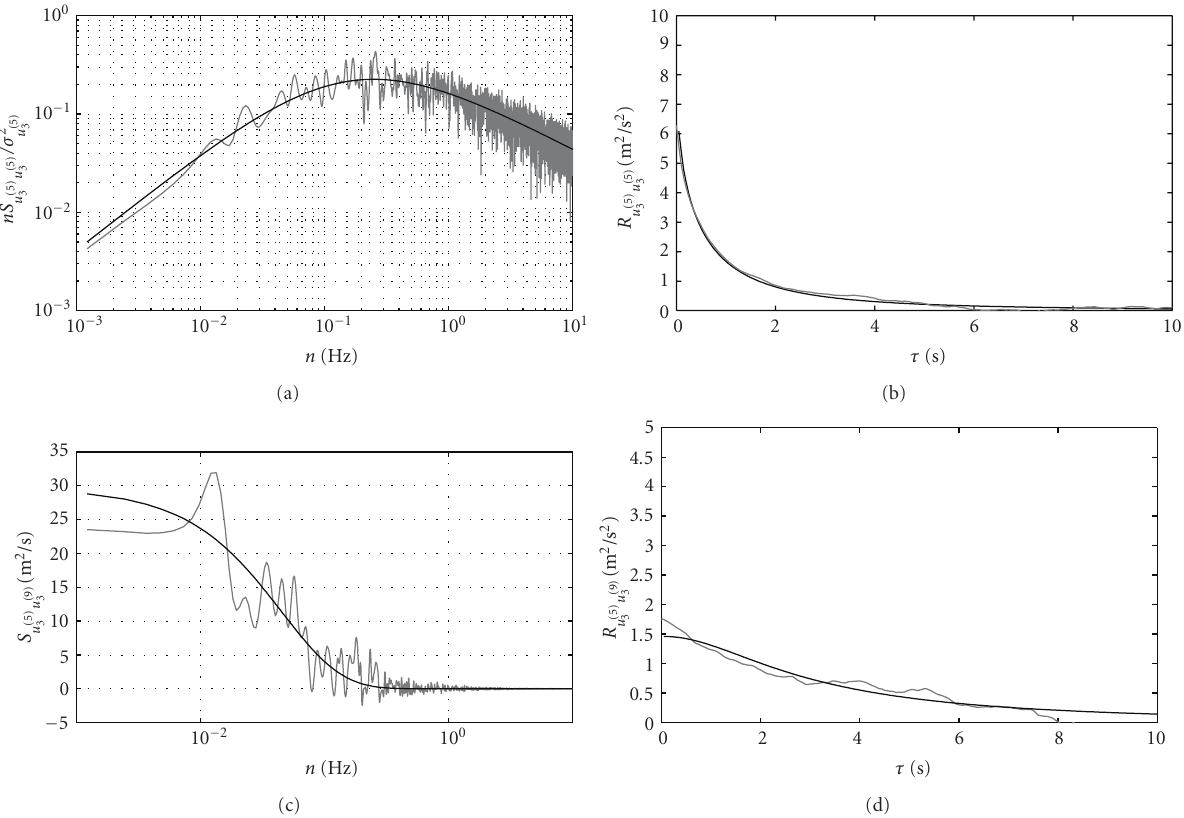
Figure 6: Example 1 using WAWS method (black lines denote target functions, gray lines denote numeric approximations): autospectrum of across-wind velocity at point 5 (a); corresponding autocorrelation function (b); cross-spectrum between across-wind velocities at points 5 and 9 (c); corresponding cross-correlation function